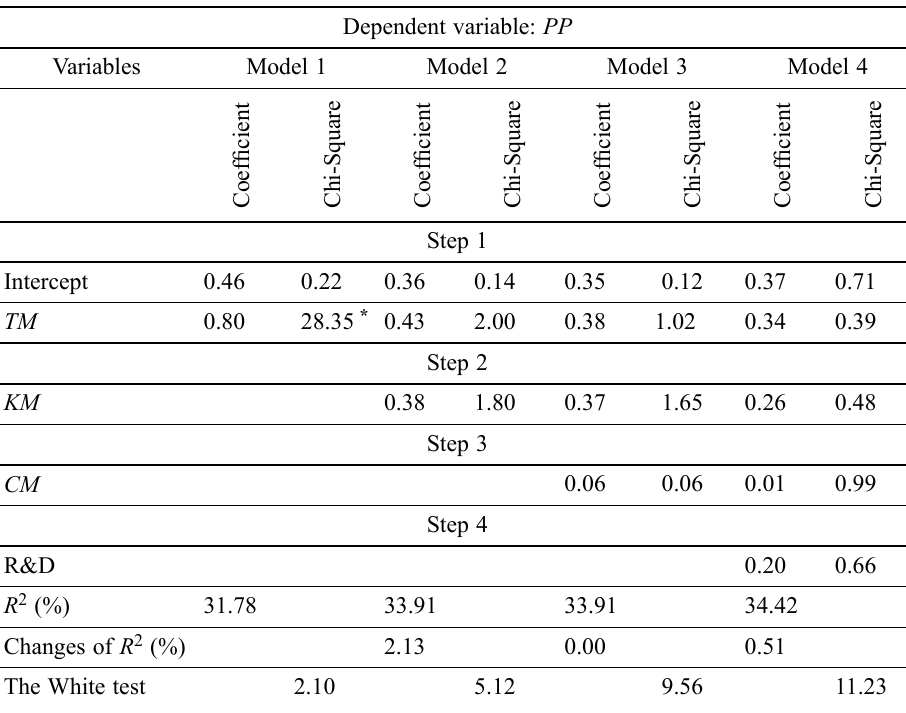
Table 2. Optimal innovation effect models created with robust regression analysis using a maximum R-squared improvement Dependent variable: